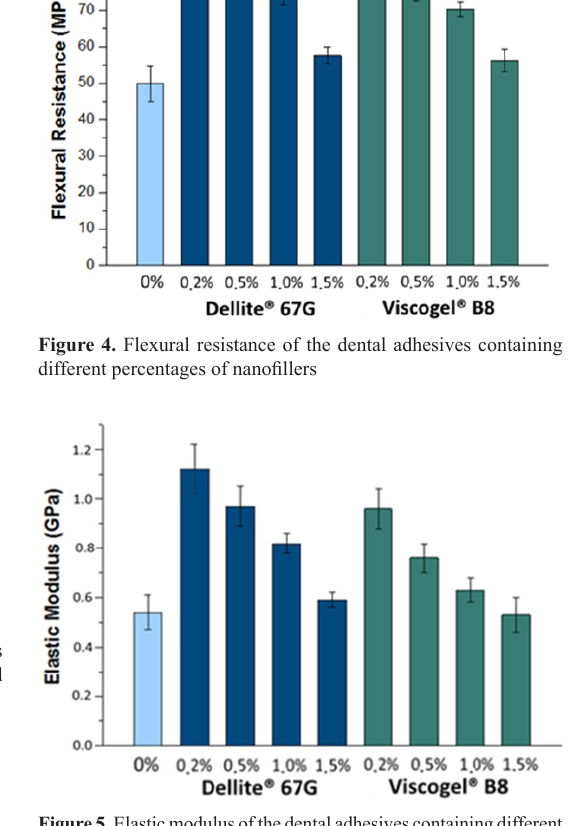
Figure 5. Elastic modulus of the dental adhesives containing different percentages of